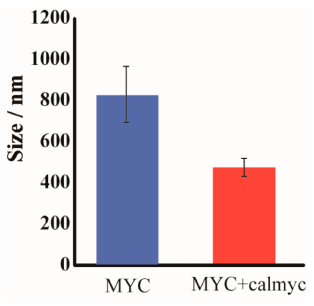
Figure 4. DLS analysis of the size of MYC incubated with Ca 2+ for 3 h with or without